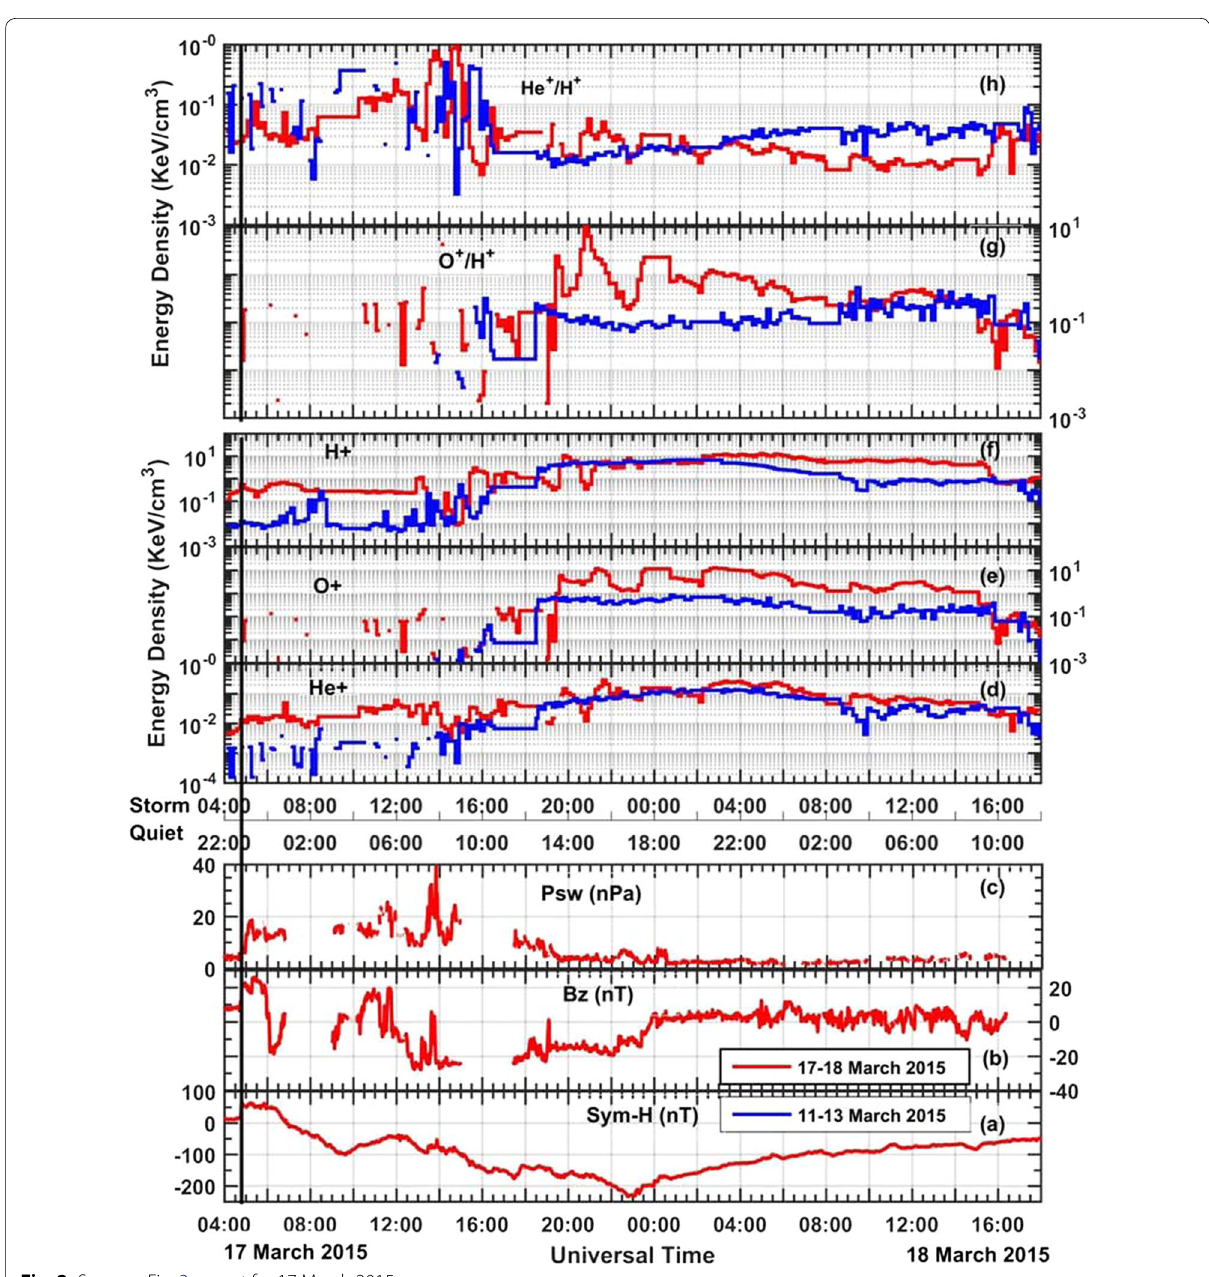
Fig. 2 Same as Fig. 3 except for 17 March